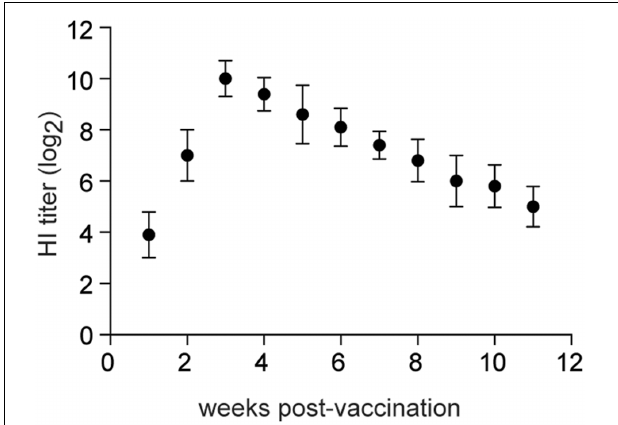
FIGURE 6 | Hemagglutination inhibition titers. Ten chickens were i.n. vaccinated with 1 × 106 log10EID 50 /0.2 ml of rTX-NS1-128 and were bled at 1-week intervals after vaccination. HI titers in sera were determined with wild-type H9N2 TX and 0.5% chicken red blood cells. The tissues of tracheas and lungs were collected and homogenized before log10 EID 50 /ml were determined. The mean and standard errors are shown.